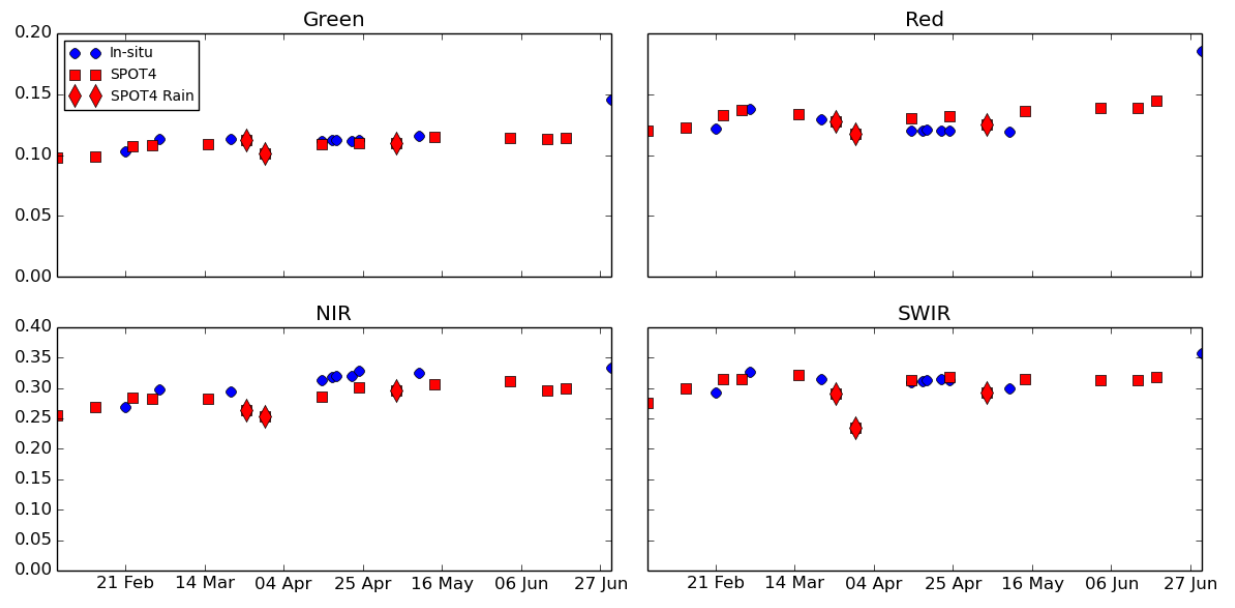
Figure 10. Comparison of SPOT-4 (Take 5) surface reflectances with Robotic Station for Characterizing Atmosphere and Surface (ROSAS) reflectances for the four bands of SPOT-4 (Take 5). The blue circles correspond to ROSAS in situ measurements, while the red squares correspond to SPOT-4 (Take 5). Three of them, observed after rain events, are marked by red